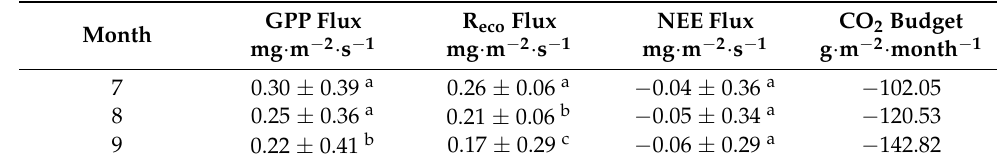
Table 1. CO 2 sink capacity of the plateau urban wetland in the warm